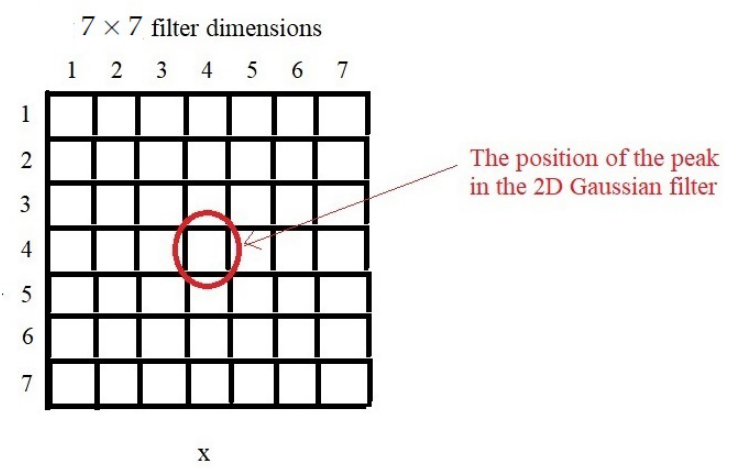
Figure 8. Gaussian 2D filter of dimensions 7